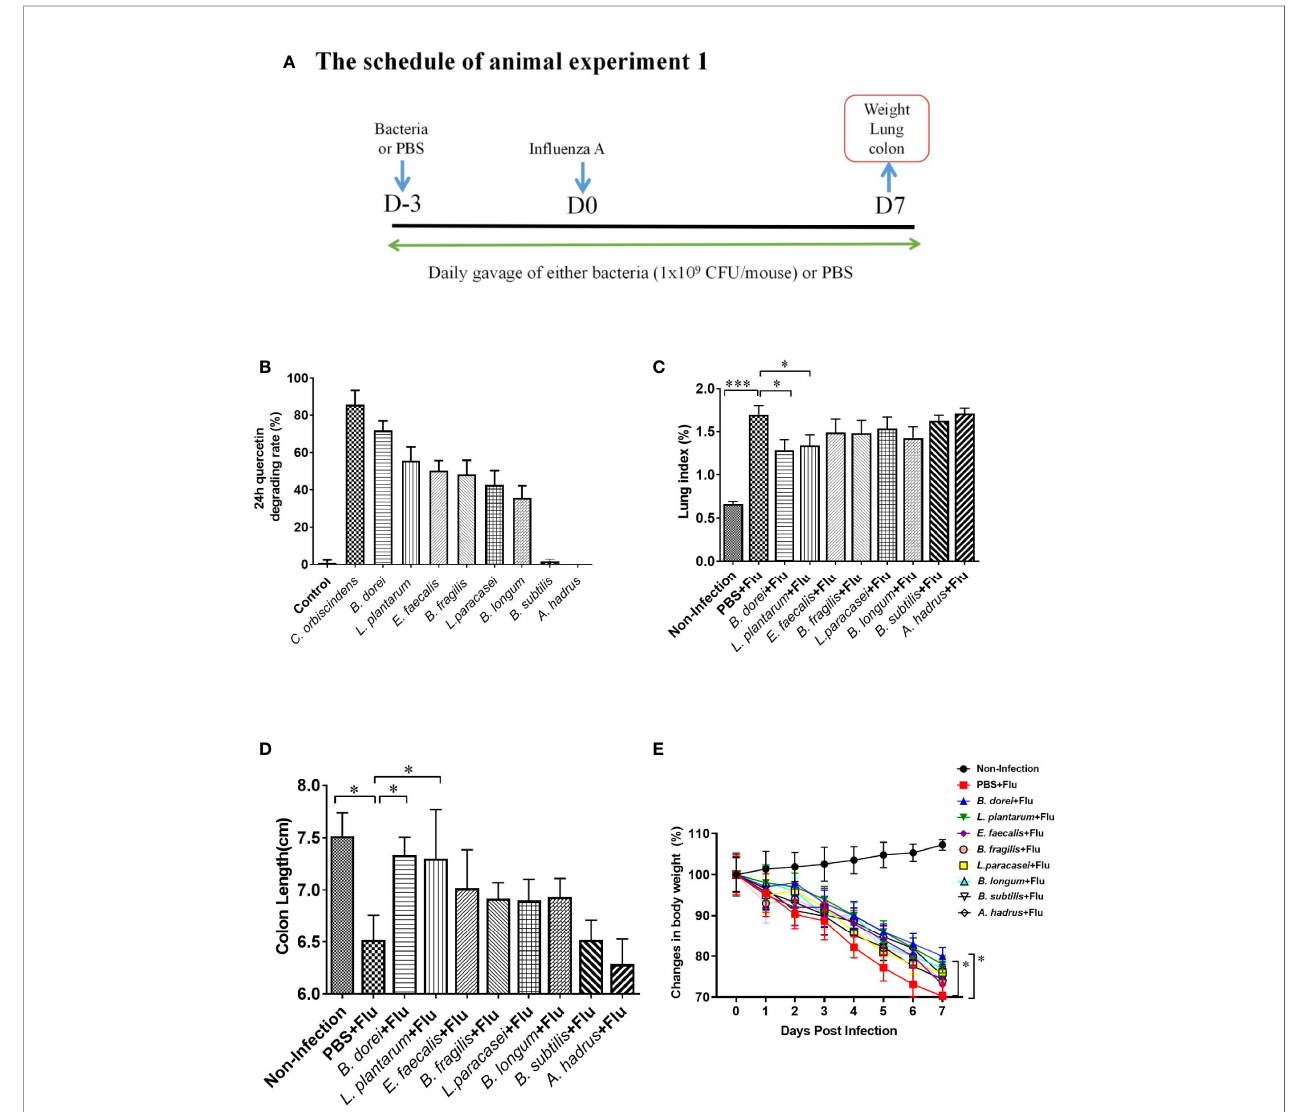
FIGURE 1 | Comparison of eight probiotics candidates for quercetin-degrading and anti-in fl uenza ef fi cacy. (A) Study design of animal experiment 1. Sixty 6-week old female C57BL/6J mice were randomly allocated to 10 groups (6 mice/group): control group (negative control), Clostridium orbiscindens group (positive control), Bacteroides dorei group ( B. dorei ), Lactobacillus plantarum group ( L. plantarum) , Enterococcus faecalis group ( E. faecalis ), Bacteroides fragilis group ( B. fragilis ), Lactobacillus paracasei group ( L. paracasei ), Bi fi dobacterium longum group ( B. longum ), Bacillus subtilis group ( B.Subtilis ), Anaerostipes hadrus group ( A. hadrus ); (B) Comparison of eight probiotics for quercetin-degrading ef fi cacy; (C) Comparison of the lung index; (D) Comparison of the colon length; (E) Dynamic trend in body weight after in fl uenza infection. The data in panel (B) are means ± SD of three independent experiments. The data in panels (C – E) are from one of three independent experiments. *p < 0.05, ***p <